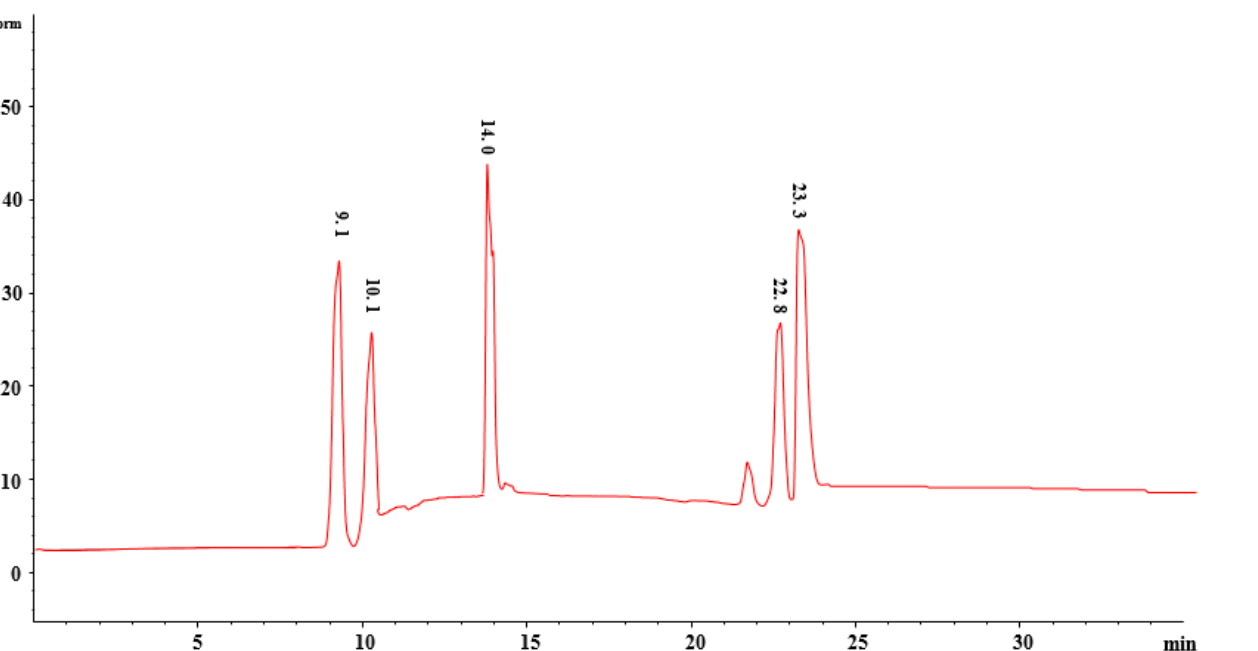
Table 5. Quantification of quinic acid, peganine, harmol, harmaline, and harmine of PHMF2 obtained from Peganum har- mala RP-HPLC subfraction.